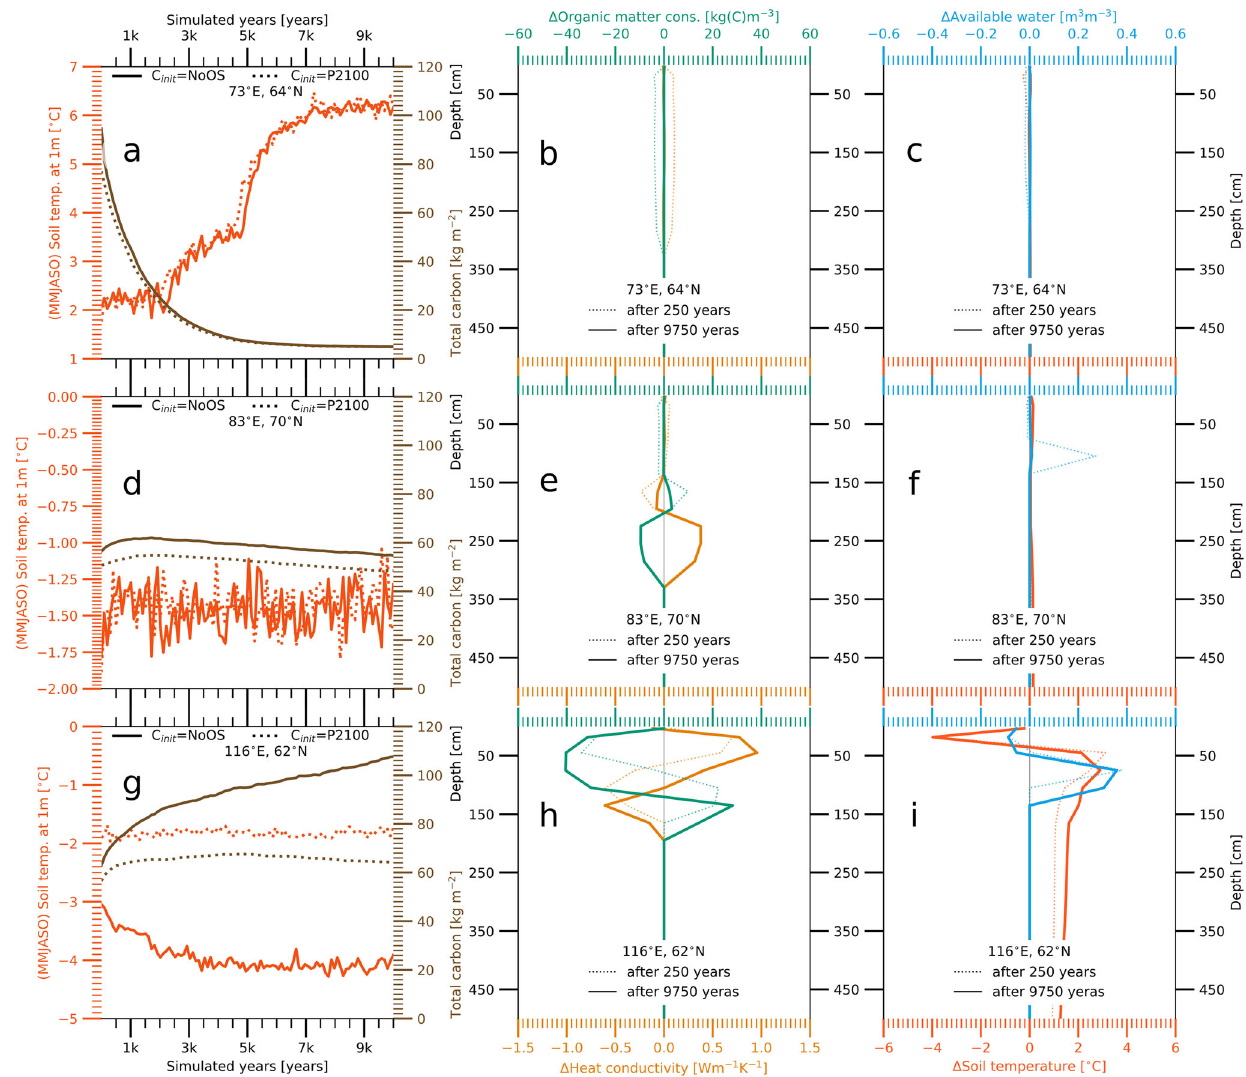
Fig. 4 Dependency of steady-state conditions on the initial soil carbon concentrations. a Simulated May – October mean soil temperatures at a depth of 1 m (red lines, left y -axis) and carbon densities (brown lines, right y -axis) in a grid cell at 73°E; 64°N. Solid lines refer to a simulation which was initialized with soil carbon pools before the temperature overshoot (NoOS), whereas dotted lines show a simulation that started from the pools after the overshoot (P2100). Both simulations were initialized with the same soil temperature pro fi le and soil water content and were similarly forced with prescribed atmospheric conditions corresponding to the target climate (PACT1.5) . All lines show 100-year averages. b Difference in soil organic matter concentration (green lines, top x -axis) and heat conductivity (yellow lines, bottom x -axis) between the two simulations (P2100-NoOS), at the beginning (dotted lines) and at the end (solid lines) of a 10,000-year period. c Same as b but for the annual maximum (monthly mean) soil temperature (red lines, top x -axis) and liquid water content (blue lines, bottom x -axis). d , g Same as a but for grid cells located at 83°E; 70°N and 116°E; 62°N. e , h Same as b but for grid cells located at 83°E; 70°N and 116°E; 62°N. f , i Same as c but for grid cells located at 83°E; 70°N and 116°E; 62°N. Please note that further examples are given in Supplementary Fig.